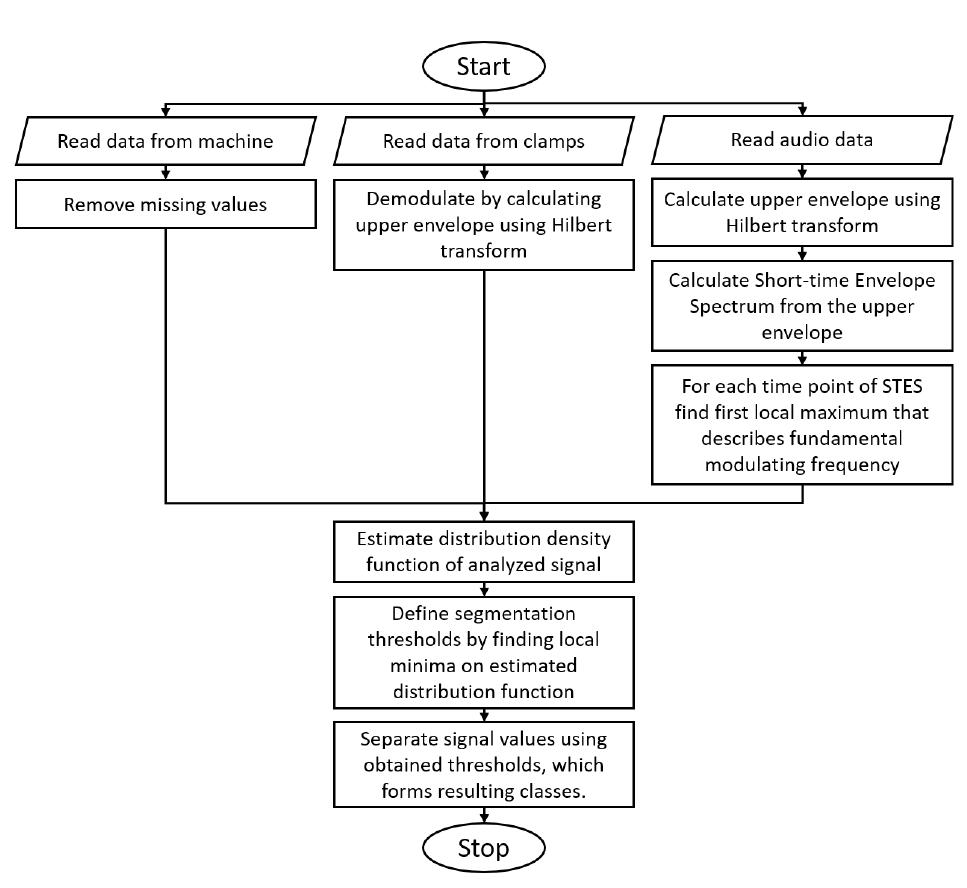
Figure 6. Flowchart of the performed